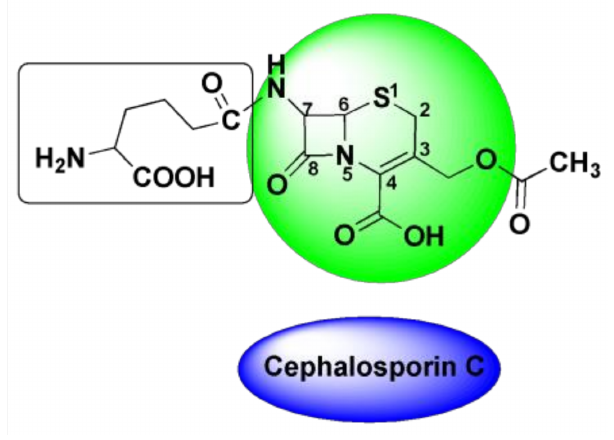
Figure 10. Structure of cephalosporin